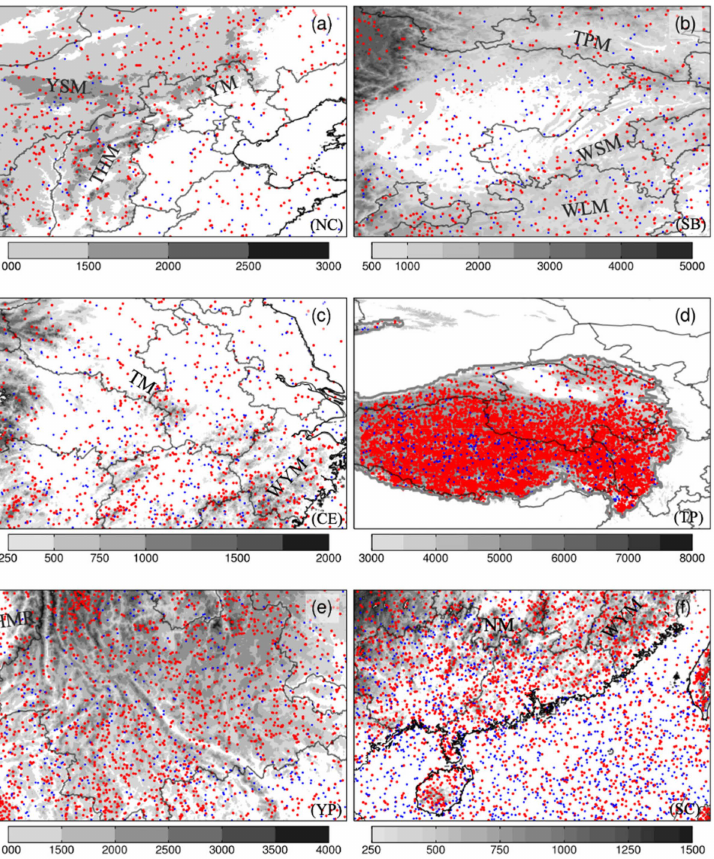
Figure 9. Scatter distribution of DCSI during daytime (red dot) and nighttime (blue dot) in ( a ) North China (NC) ( b ) Sichuan Basin (SB) ( c ) Central Eastern China (CE) ( d ) Tibetan Plateau (TP) ( e ) Yunnan-Guizhou Plateau (YP) ( f ) South China (SC), respectively. The grey shade indicates terrain height (units: